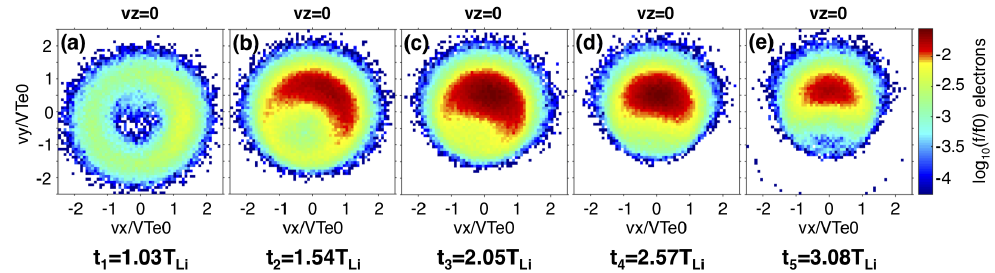
Figure 5. Virtual time series of five electron VDFs “measured” by a virtual satellite launched into the simulation domain. We illustrate the space of perpendicular velocities for v z = 0. The colour scale used is